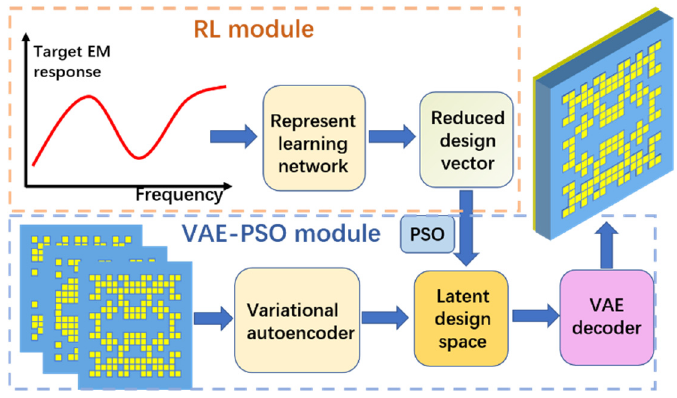
Figure 1. Flowchart of the hybrid framework.